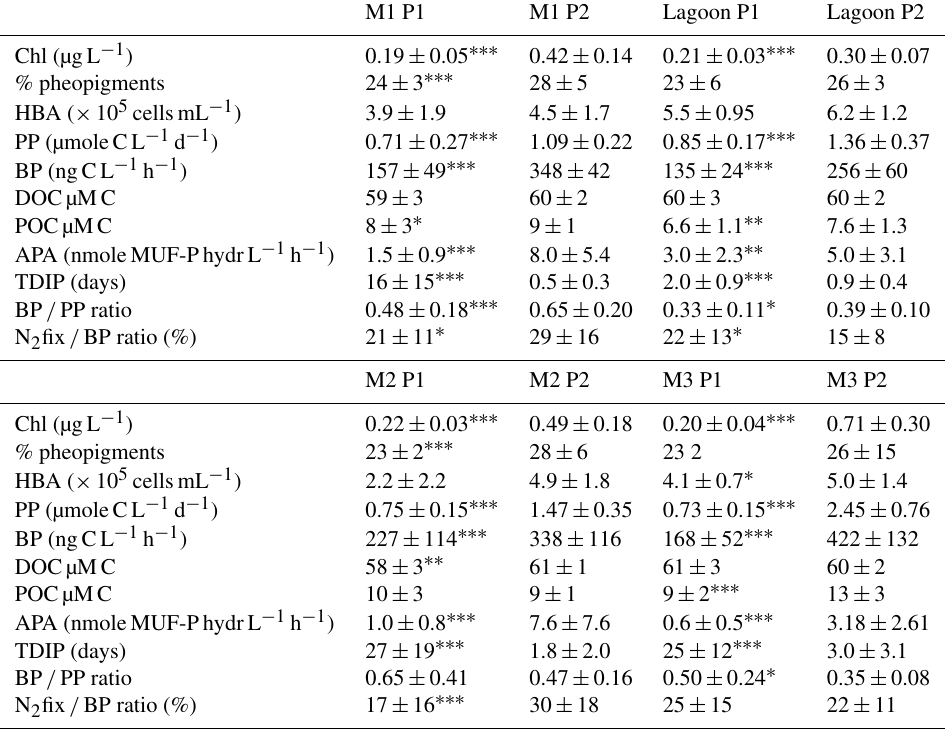
Table 1. Averages ± standard deviations of some parameters during phases P1 (from day 5 to day 14) and P2 (from day 15 to day 23) in the three mesocosms M1, M2, M3 and in the lagoon waters. HBA: heterotrophic prokaryotic abundances, BP: heterotrophic prokaryotic production, APA: alkaline phosphatase activity, TDIP: turnover time of DIP. N 2 fixation contribution to BP (N 2 fix / BP ratio, in %) is based on a C / N of 6.8 for heterotrophic